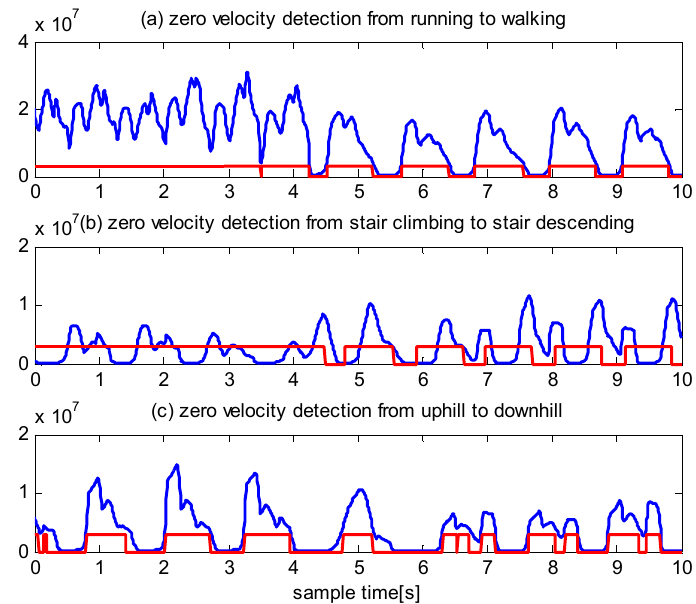
Figure 9. Zero velocity detection using method proposed in [11]. The vertical unite is dimensionless numbers.